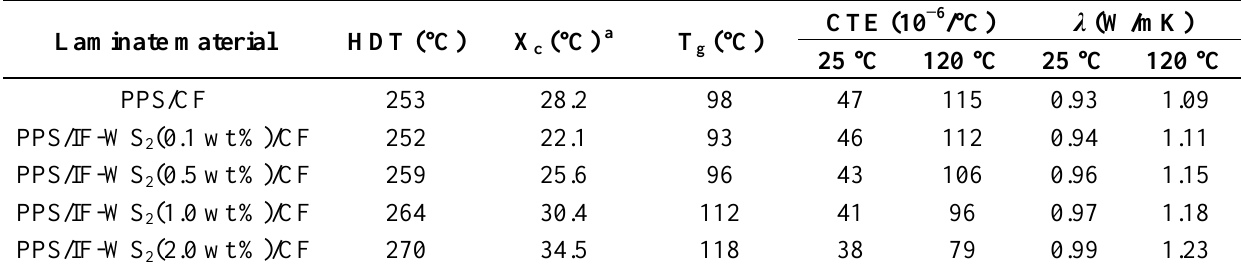
Table 2. Thermal conductivity ( λ ), degree of crystallinity (X (HDT), glass transition temperature (T PPS/IF-WS /CF 2